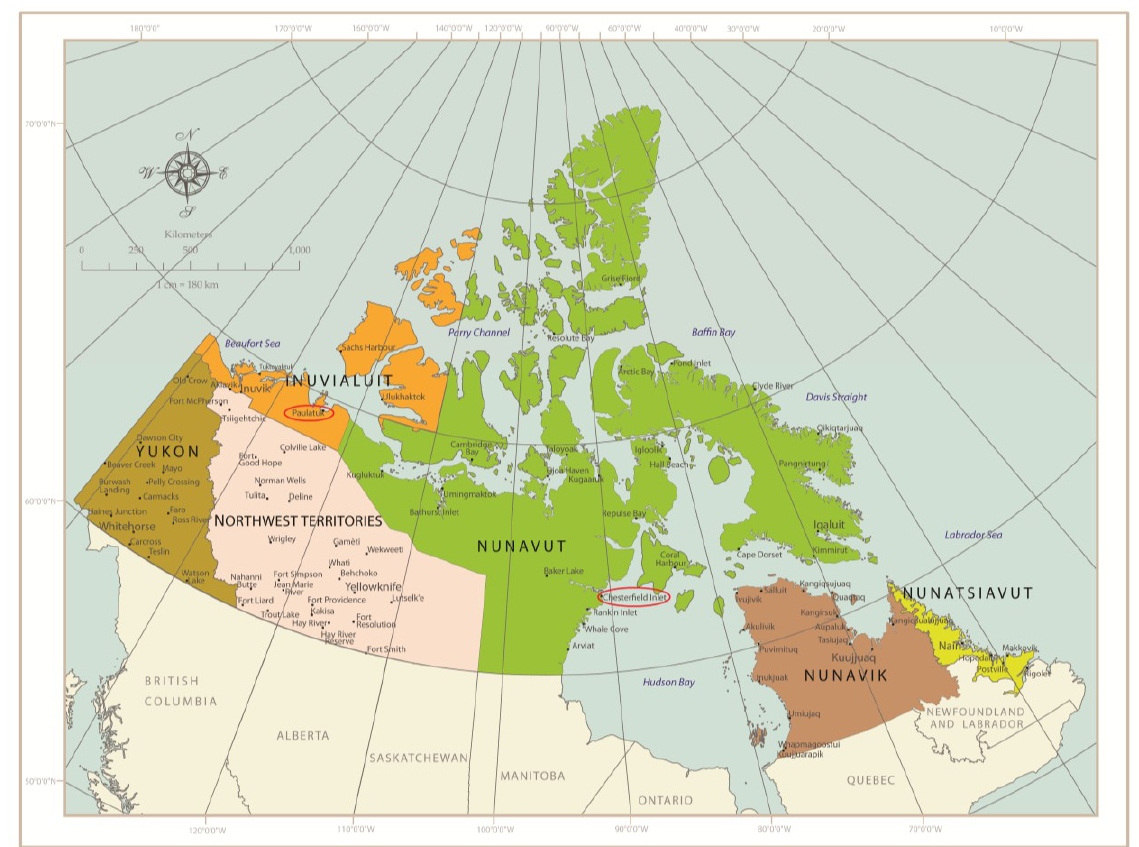
Figure 1. Communities of the Canadian arctic. Chesterfield inlet and Paulatuk are highlighted in red (Map created by: Noreen